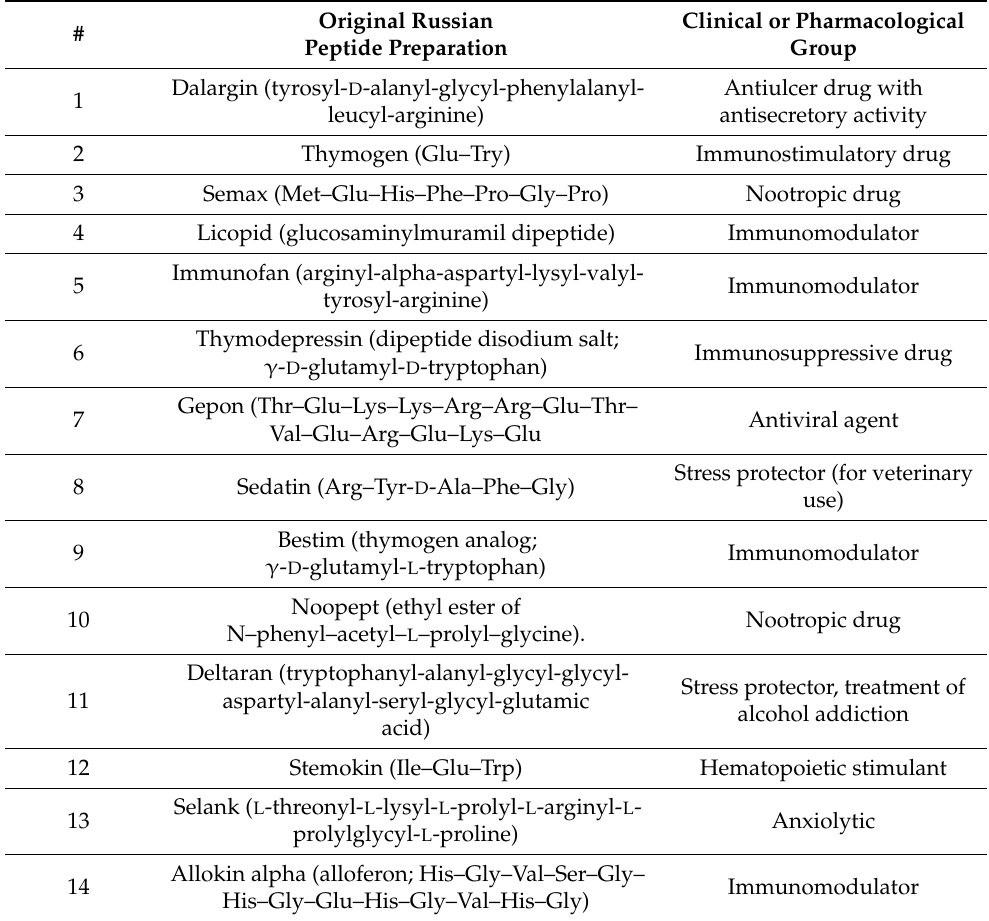
Table 1. Peptide drugs developed in Russia and their clinical and pharmacological